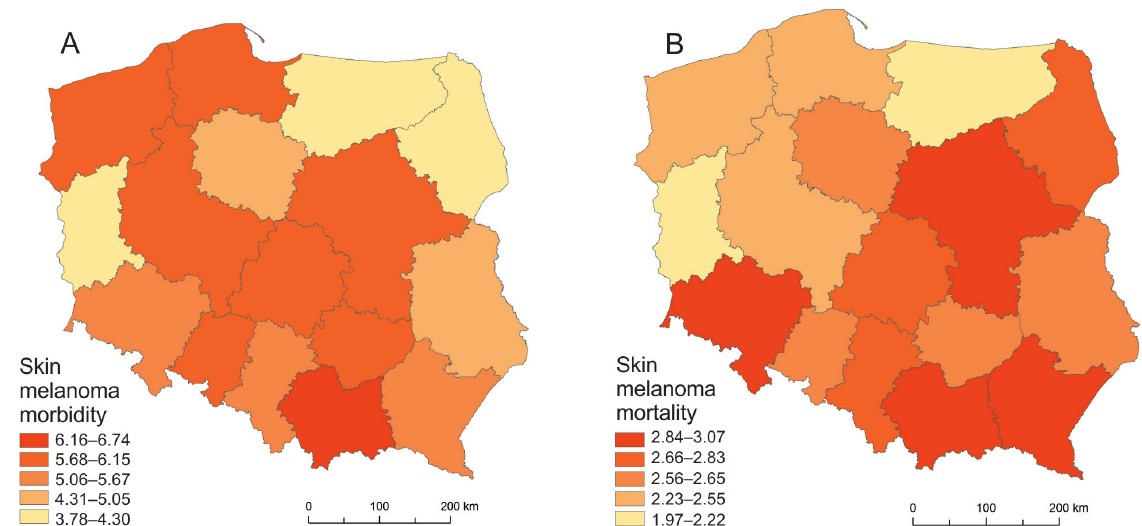
Fig. 4. Mean yearly number (per 100 000 inhabitants, 1999–2012) of skin melanoma morbidity (A) and mortality